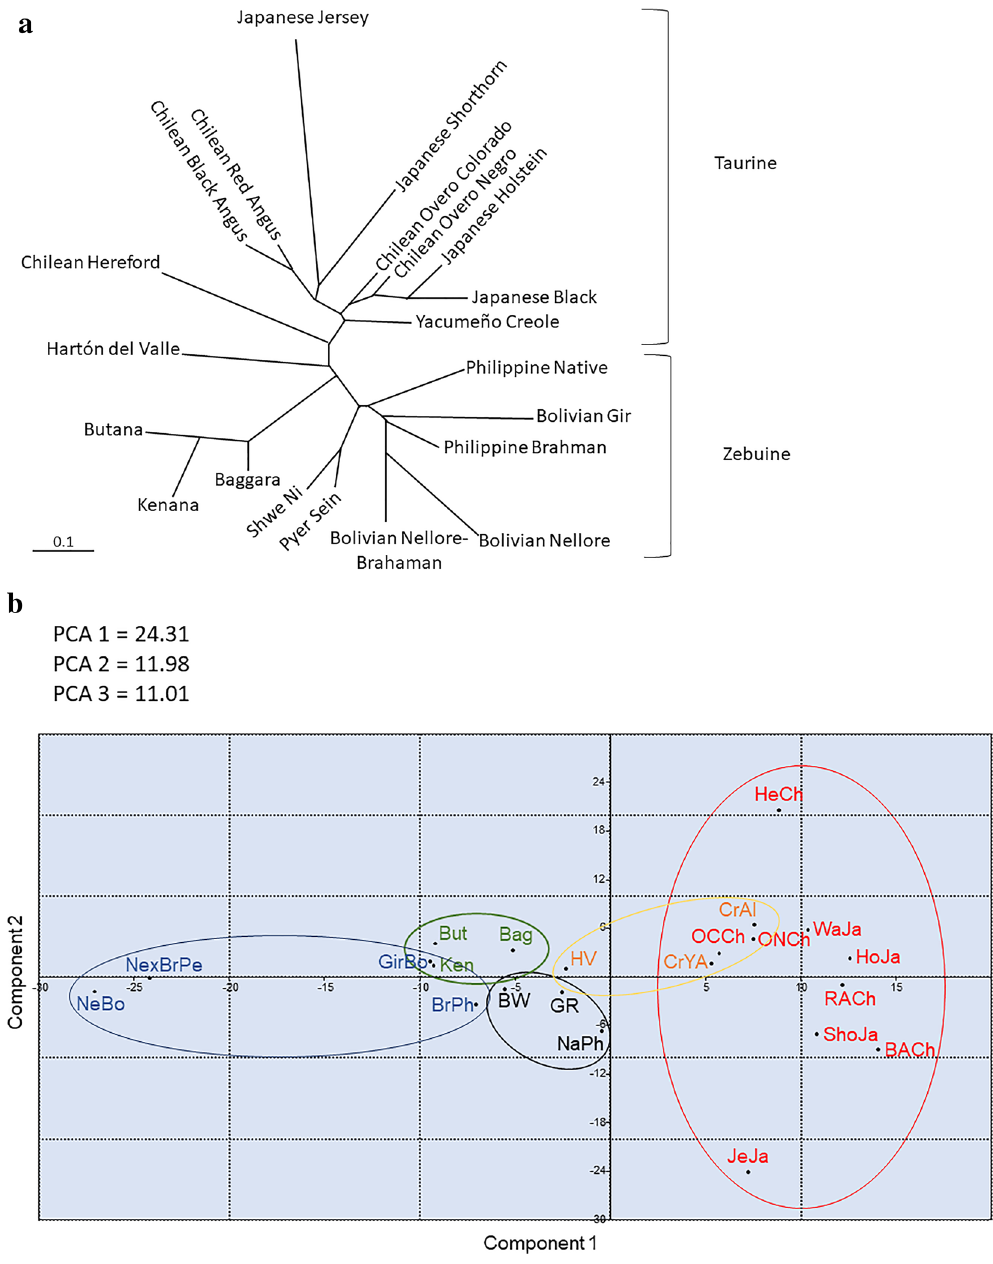
Figure 6. ( a ) Neighbor-joining dendrogram constructed from a matrix of D A genetic distances. ( b ) Principal Component Analysis of allele frequencies from the BoLA-DRB3 gene in 22 breeds. But = Butana, Ken = Kename, Bag = Baggara, BW = Pyer Sein. GR = Shwe Ni, NaPh = Philippine native, GirBo = Bolivian Gir, BrPh = Philippine Brahman, BrxNePe = Peruvian Brahman × Nellore crossbreed, NeBo = Bolivian Nellore, CrHV = Creole Hatón del Valle, CrYa = Creole Yacumeño, Creole Highland, HeCh = Chilean Hereford, OCCh = Chilean Overo Colorado, ONCh = Chilean Overo Negro, HoJa = Japanese Holstein, WaJa = Japanese Black, BACh = Chilean Black Angus, RACh = Chilean Red Angus, ShJa = Japanese Shorthorn and JeJa = Japanese